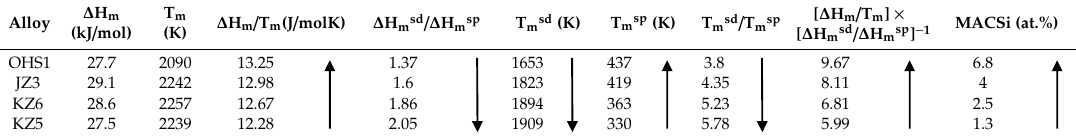
Table 4. Alloy parameters for the macrosegregation of Si in the cast alloys KZ5, KZ6, JZ3, OHS1.